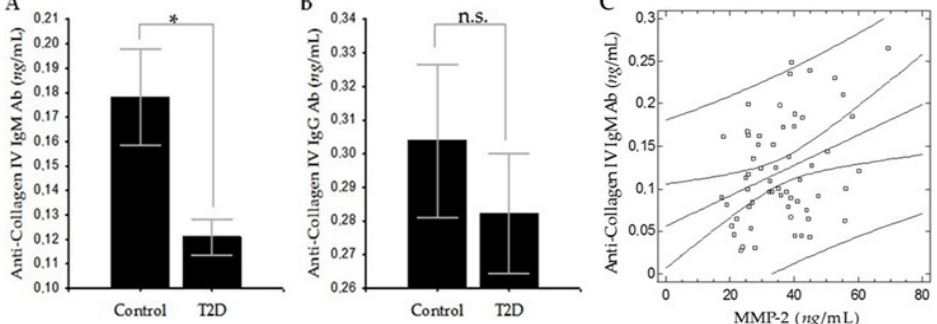
Figure 1. ( A ) Serum levels of ACIVAbs IgM in T2D group vs. control group. ( B ) Serum levels of ACIVAbs IgG in T2D group vs. control group. ( C ) Relationship between ACIVAbs IgM and MMP-2 in the T2D group. Data are represented as mean ± SD. * p < 0.05, n.s.—not significant.